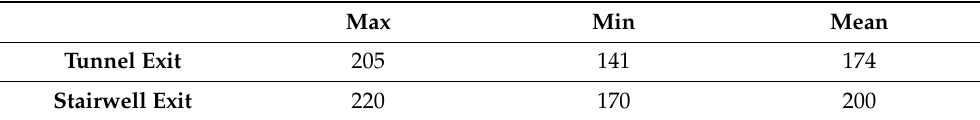
Table 4. Occupants’ evacuation time (sec) distribution in drill no.1 (clear environment).